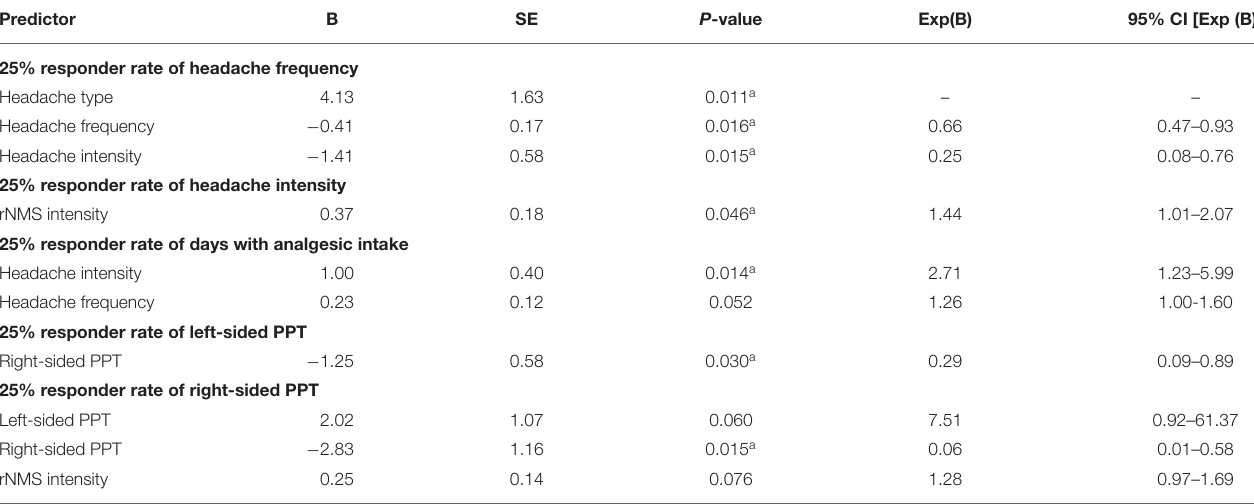
TABLE 3 | Results of the multivariate analyses of response predictors of repetitive neuromuscular magnetic stimulation applied to the trapezius muscles in n = 30 patients affected by episodic migraine.